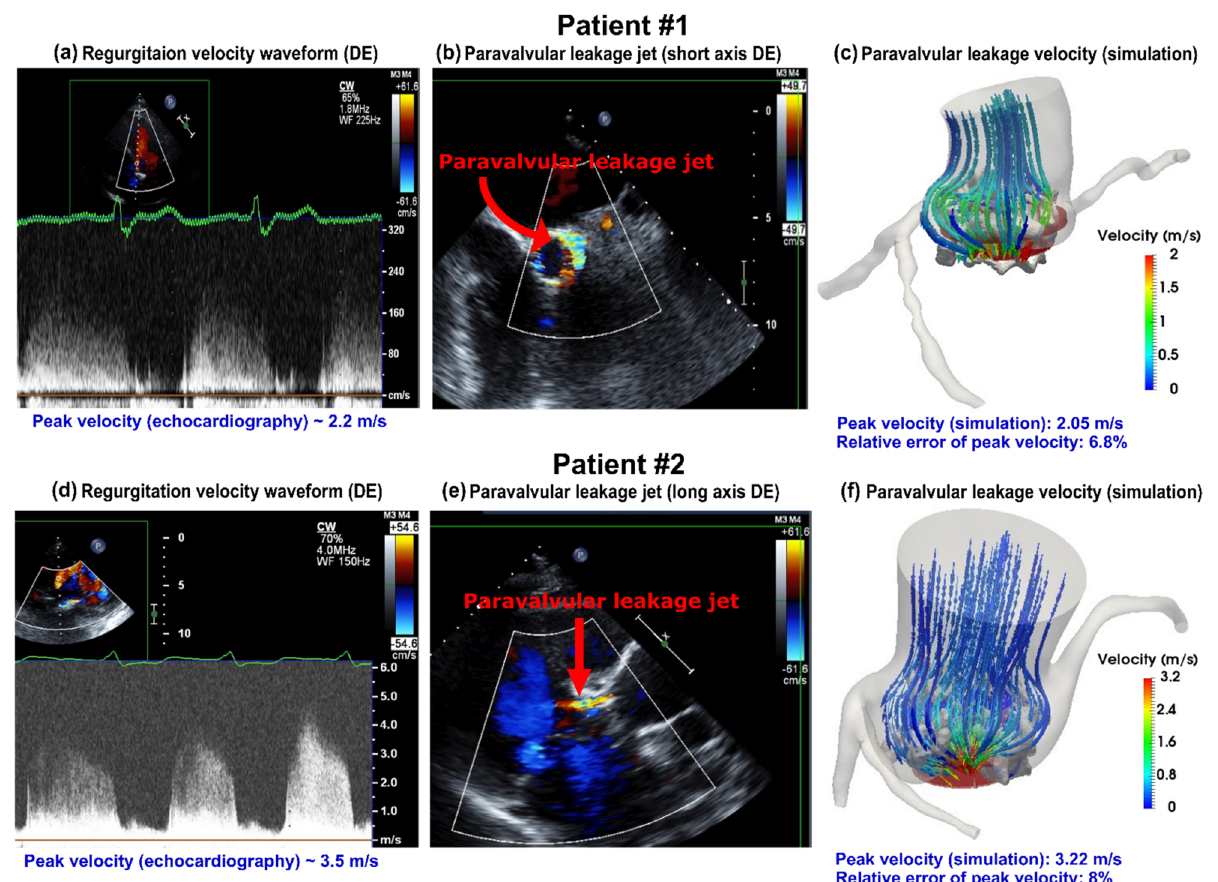
Figure 8. Validation: Doppler-based LPM and FSI framework versus patients Doppler echocardiography data. ( a ) & ( d ) Regurgitant flow waveform during diastole in patients #1 and #2; ( b ) Parasternal short axis view of PVL during diastole in patient #1; ( e ) Parasternal long axis view of PVL during diastole in patient #2; ( c ) & ( f ) PVL flow velocity streamlines during diastole in patients #1 and